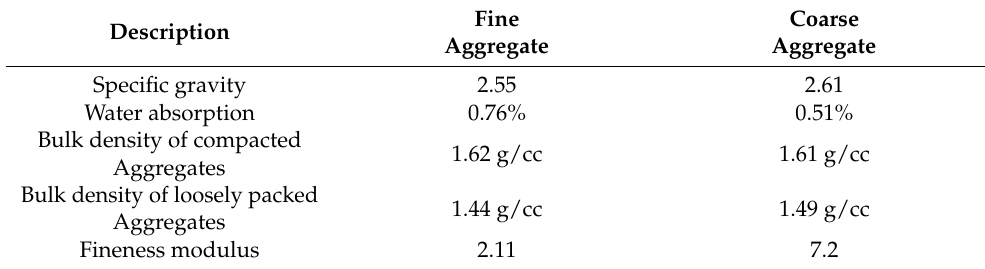
Table 3. Properties of fine and coarse